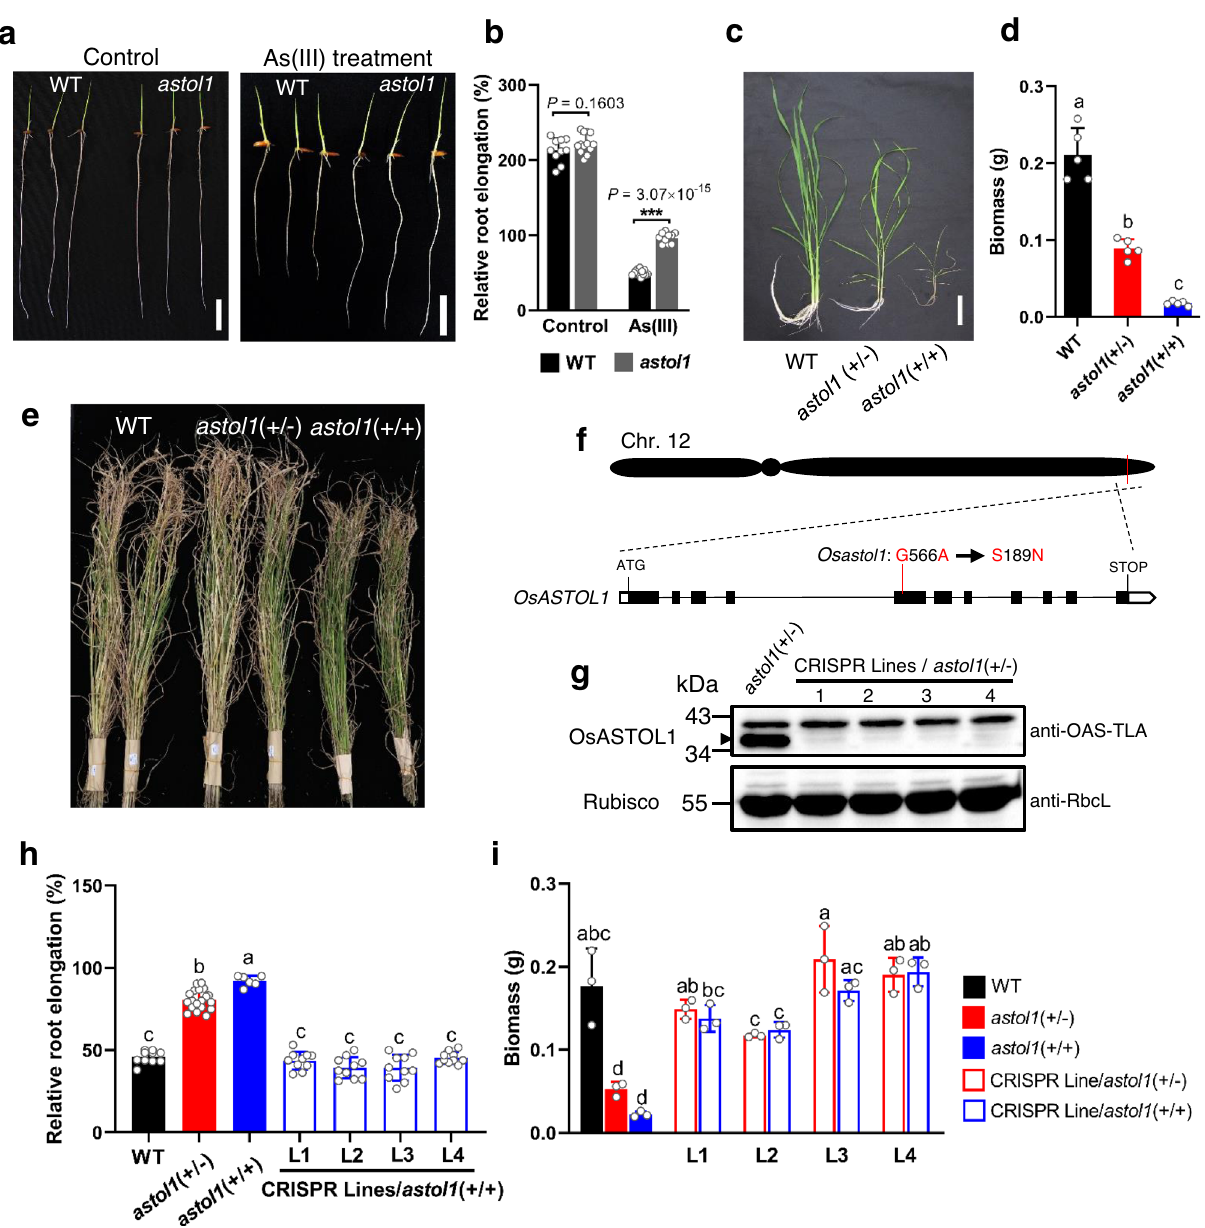
Fig. 1 Phenotypes of astol1 mutant and MutMap-based cloning of OsASTOL1 . a The phenotype of WT and astol1 mutant treated with 0 or 20 μ M As(III) for 2 days. Three plants for each genotype are shown. Scale bars, 20 mm. b Relative root elongation of WT and astol1 mutant treated with 0 or 20 μ M As (III) for 2 days. Asterisks indicate signi fi cant difference by two-sided Student ’ s t test: *** P < 0.001. c Growth phenotype of 5-week-old WT, astol1 ( + / − ) and astol1 ( + / + ) mutant grown hydroponically. Two plants for each genotype are shown. Scale bars, 10 cm. d Biomass of 5-week-old WT, astol1 ( + / − ) and astol1 ( + / + ) mutant grown hydroponically. e Wild-type rice and astol1 mutants were grown in a paddy fi eld until maturity. f Chromosomal location and gene structure of OsASTOL1 . White and black boxes represent untranslated regions and exons, respectively, and the lines between them represent introns. Red line indicates the mutation site. g Validation of knock-out OsASTOL1/ OsASTOL1 S189N protein in four independent CRISPR lines in the astol1 ( + / − ) background using immunoblot analysis. OsASTOL1 protein (lower band) is detected by AtOAS-TL A1 antibody (anti-OAS-TLA) and the Rubisco large subunit is used as a loading control. The experiment was repeated three times and similar results were obtained. h Relative root elongation of WT, astol1 ( + / − ), astol1 ( + / + ), and four independent CRISPR lines in the astol1 ( + / + ) background. Plants were treated with 20 μ M As(III) for 2 days. i Biomass of 5- week-old WT, astol1 ( + / − ), astol1 ( + / + ), and CRISPR lines in astol1 ( + / − ) or astol1 ( + / + ) background. DW, dry weight. WT, wild type. astol1 ( + / − ), astol1 heterozygote. astol1 ( + / + ), astol1 homozygote. Data in b , d , h , and i are shown as means ± s.d., n = 10 for WT (control) and astol1 (As(III) treatment), 13 for astol1 (control) and WT (As(III) treatment) ( b ), 5 ( d ), 6 for astol1 ( + / + ), 10 for WT and all CRISPR lines/ astol1 ( + / + ), 19 for astol1 ( + / − ) ( h ) or 3 ( i ) biological replicates; each biological replicate represents an individual plant. Different letters in d , h , and i indicate signi fi cant differences ( P < 0.05) using one-way ANOVA followed by Tukey ’ s